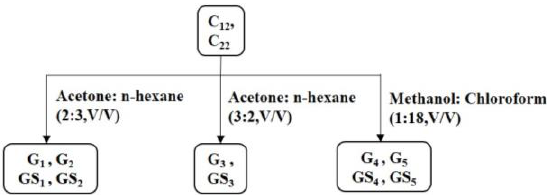
Figure 19. Purification process of DHP ether component.